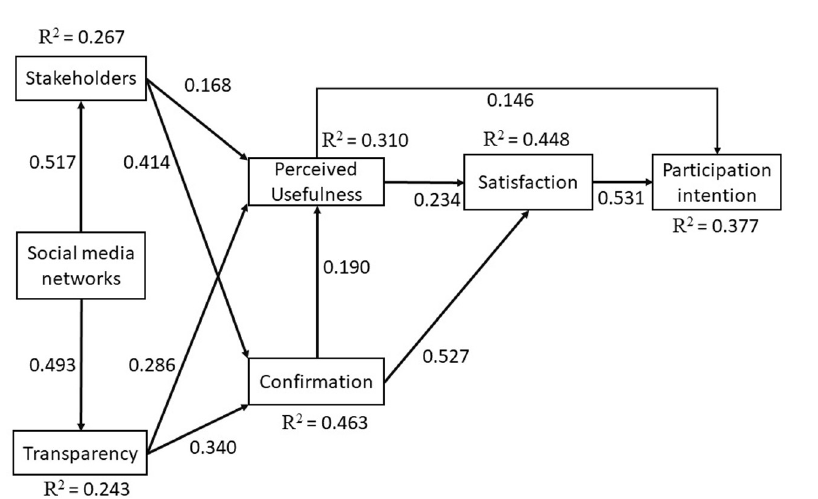
Fig 2. PLS algorithm